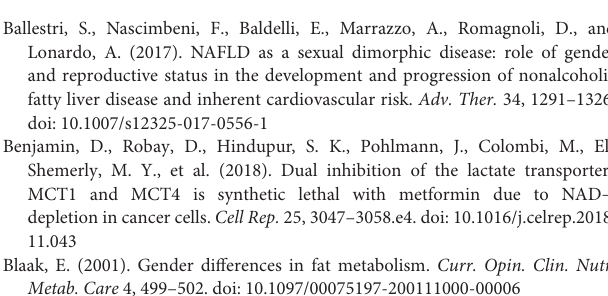
Supplementary Figure 2 | Higher magnified images of (A) MAP-2 + MCT2 + and (B) GFAP + MCT4 + in the OVX groups. Supplementary Table 1 | Primer sequences for